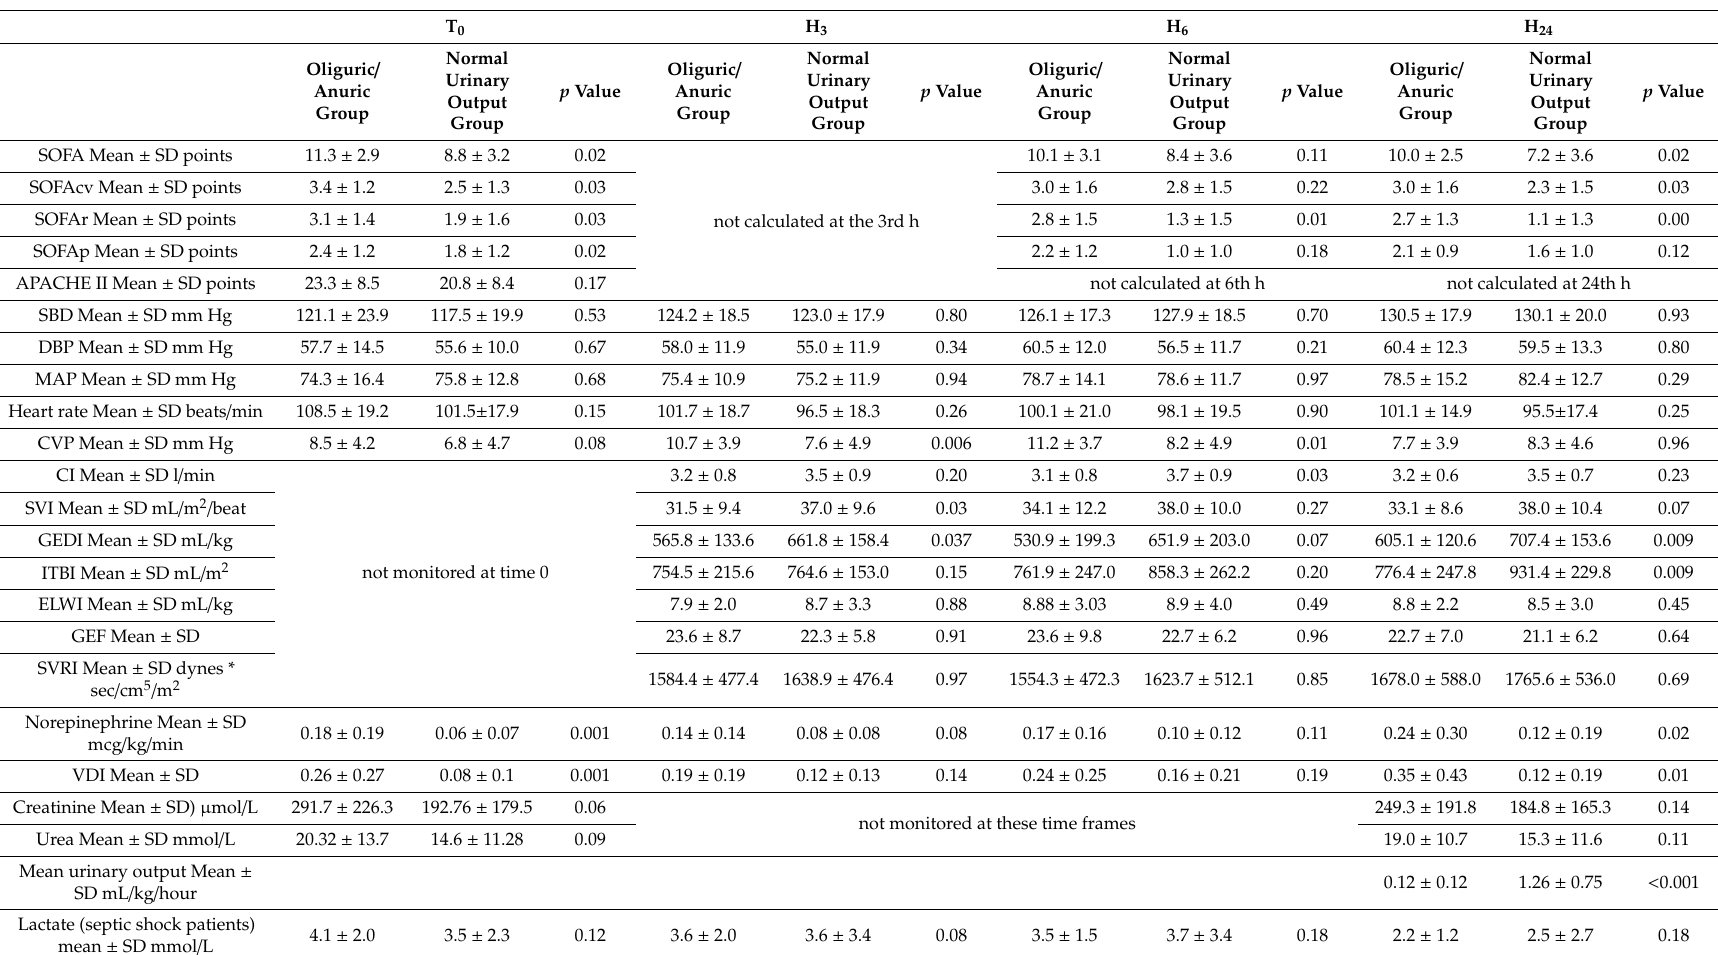
Table 2. The hemodynamic parameters of the two groups of